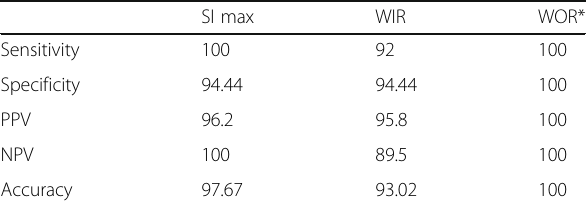
Table 6 ROC curve analysis for prediction of malignancy according to MR perfusion measurements in correlation with histopathological diagnosis